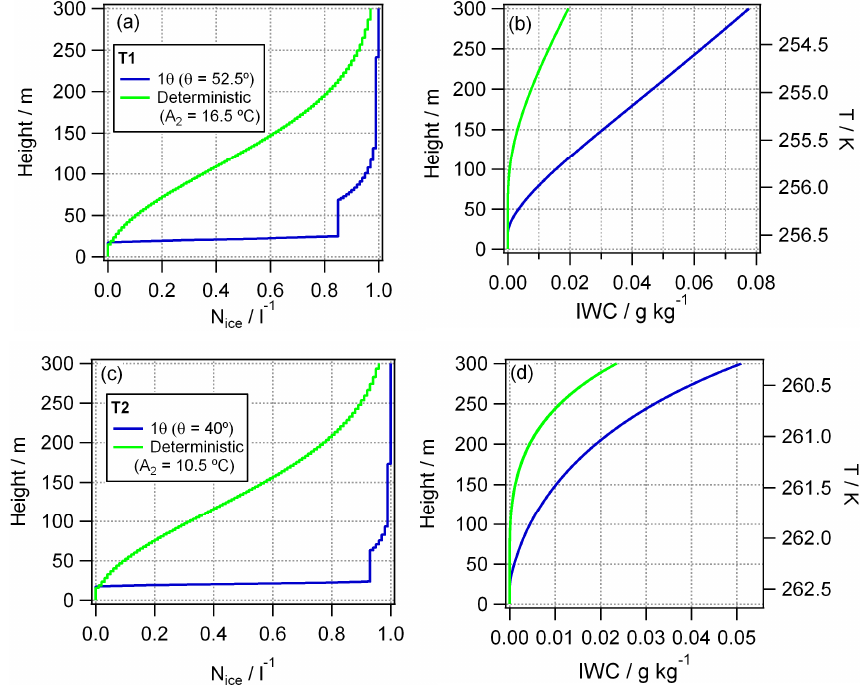
Fig. 7. Evolution of the ice number concentration N ice of an IN population with N IN = 1l − 1 and ice water content IWC for heterogeneous freezing in temperature regime T1 (a, b) and T2 (c, d) as marked in Fig. 6. For the two temperature regimes, different parameter sets ( θ , A 1 , A 2 ) were applied (Table 1)